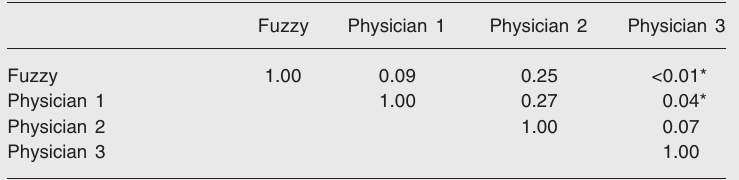
Table 5. Statistical significance (P value) of the difference among the areas under the ROC curves presented in Figure 4. Fuzzy Physician 1 Physician